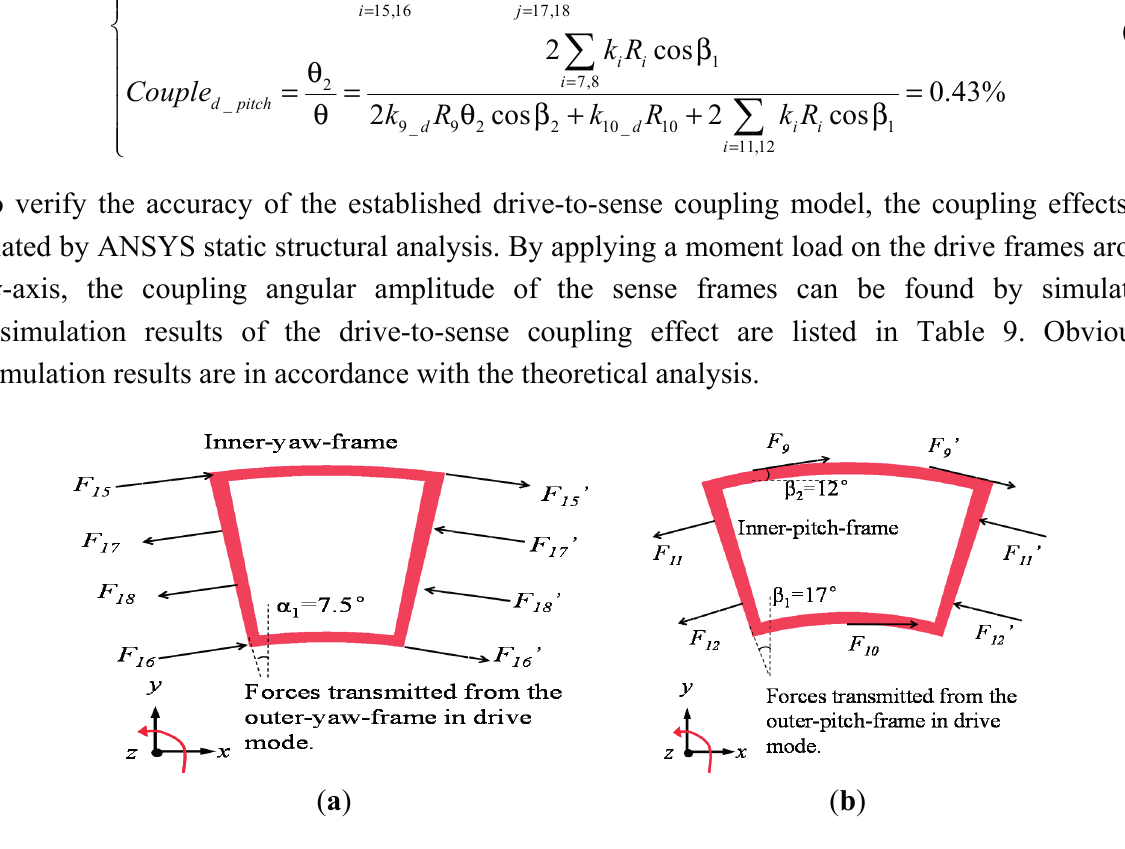
Figure 7. Mathematic models from drive to sense coupling effect: ( a ) Drive to yaw. ( b ) Drive to pitch/roll. Table 9. Simulation results of drive-to-sense